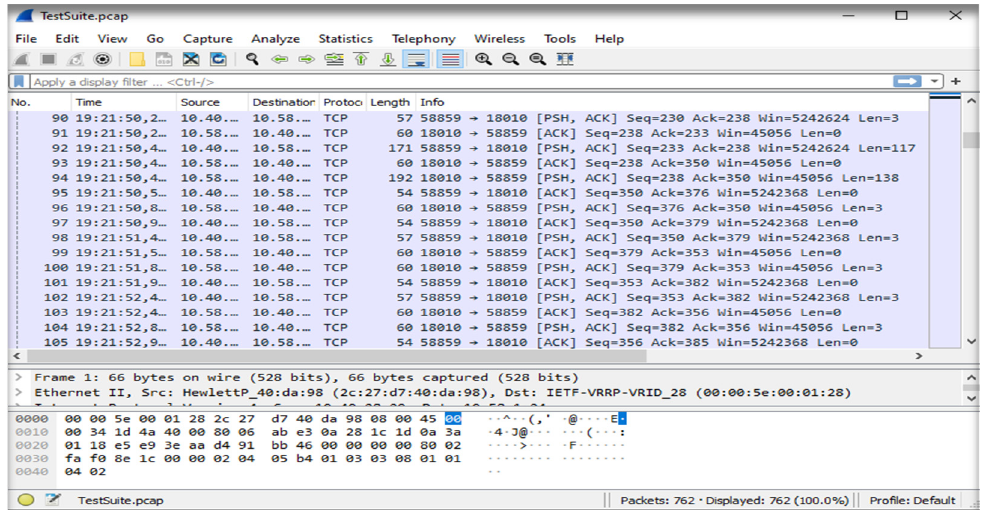
Figure 1. Targeting System Architecture.